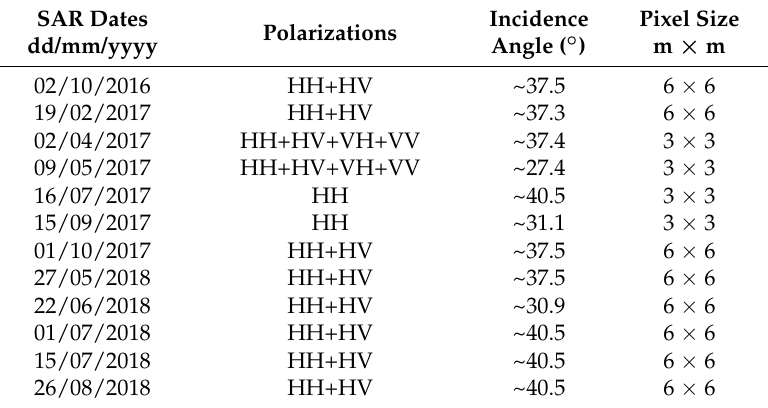
Table 1. Characteristics of ALOS-2